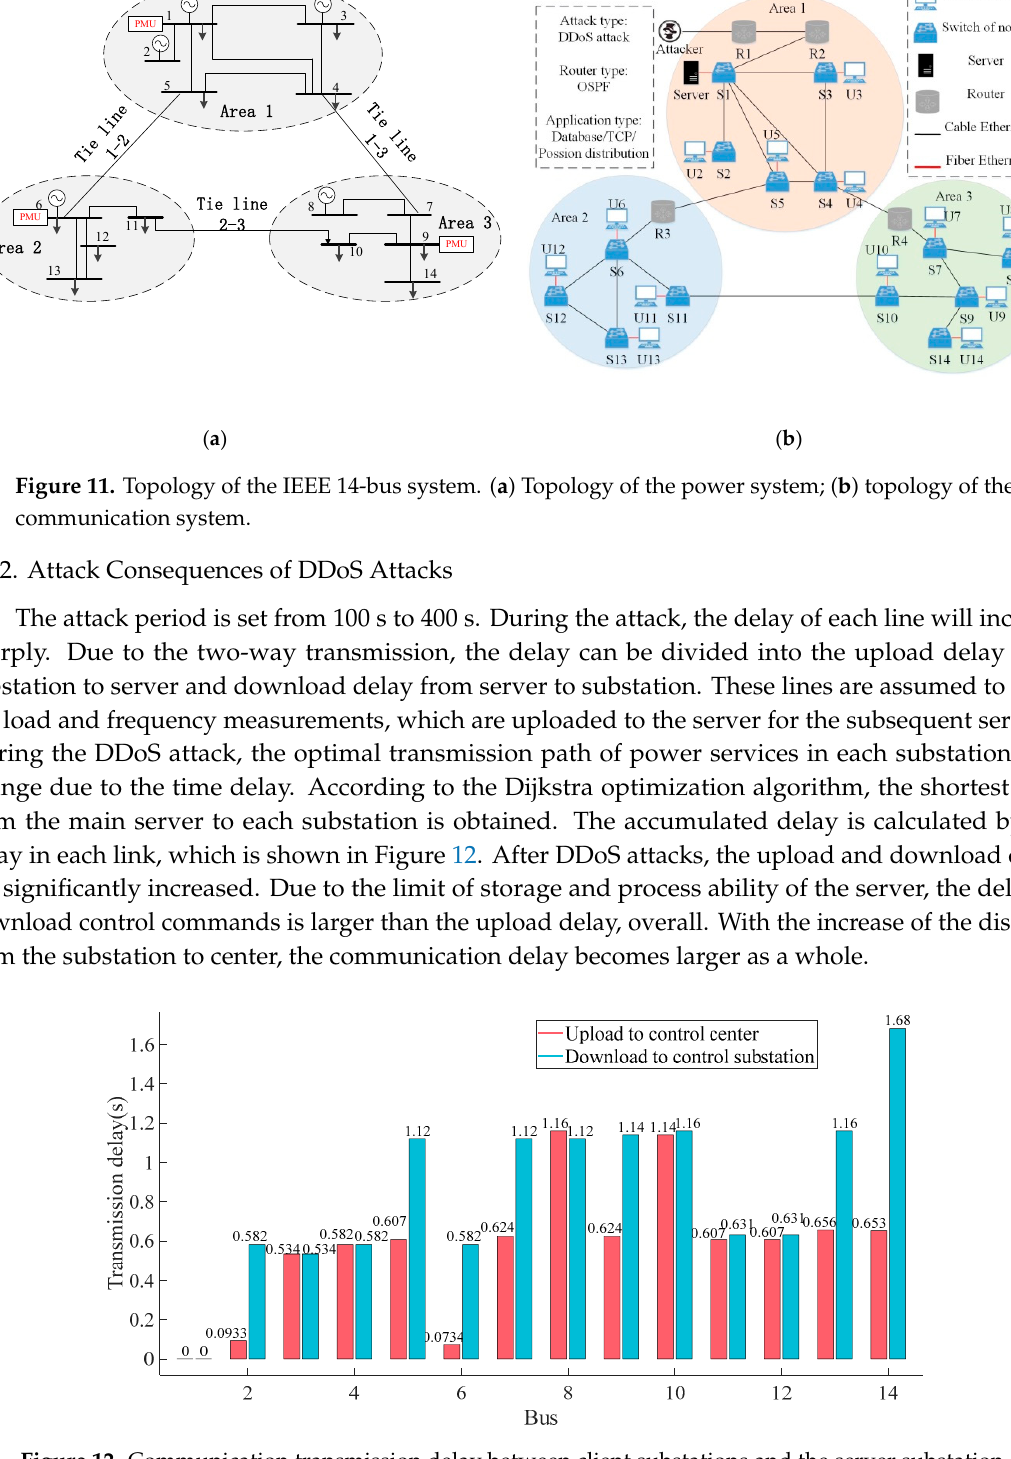
Figure 10. Cyber physical architecture of IEEE 14-bus system.